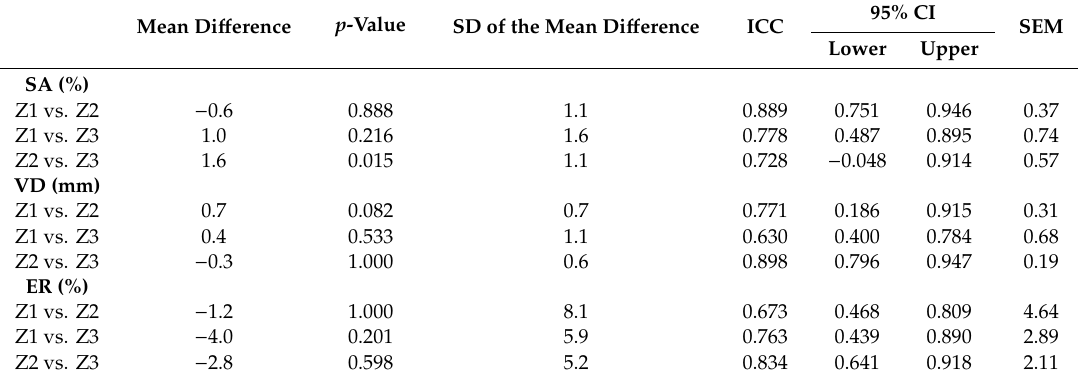
Table 3. Inter-zone comparison of shock absorption (SA), vertical deformation (VD), and energy restitution (ER). ‘Mean Di ff erence’ is the zone on the left side minus the zone on the right. p